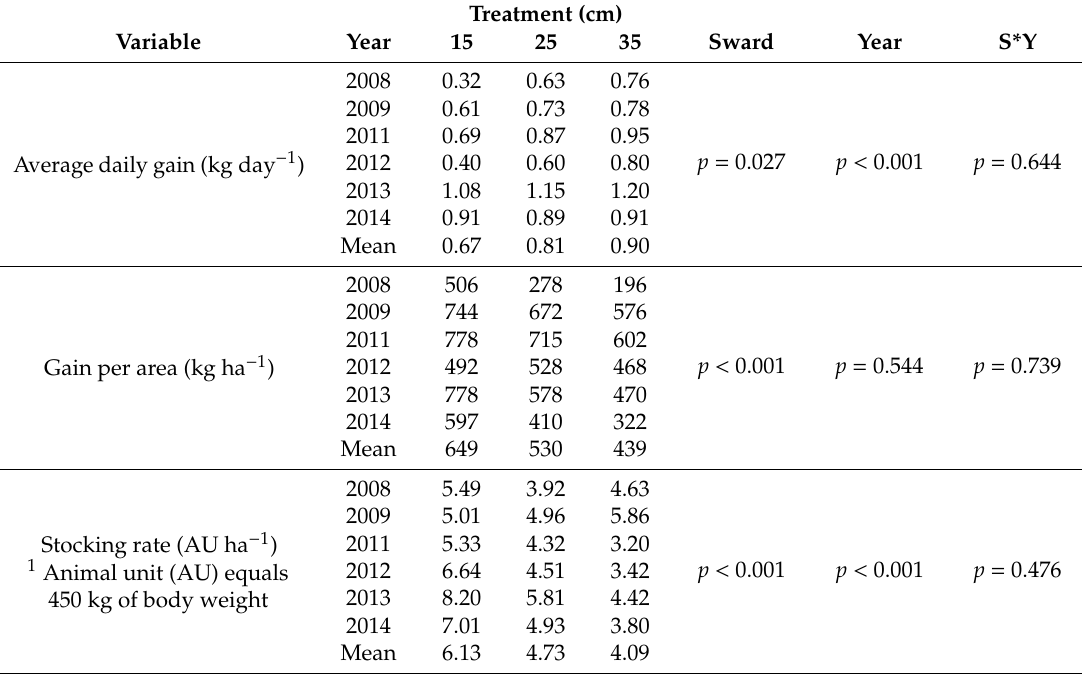
Table 5. Animal performance (gain per animal and area) in Marandu grass pastures managed at di ff erent sward heights 1